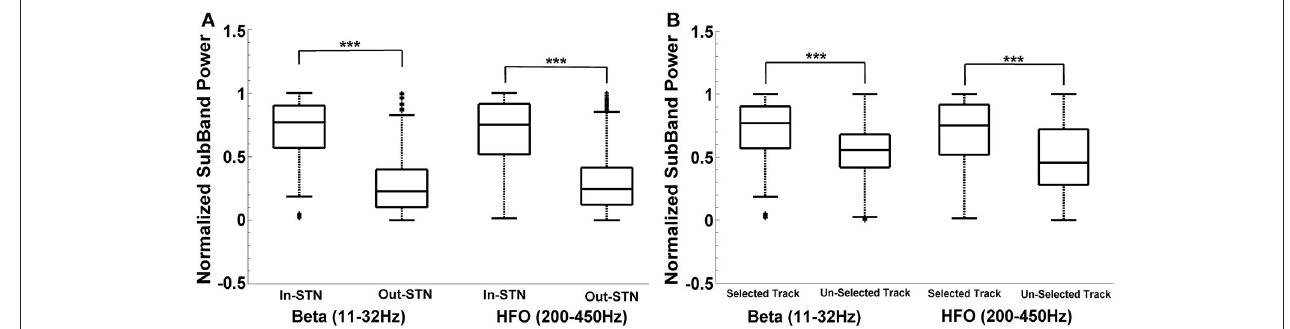
FIGURE 8 | Intra-track and inter-track differences of LFP spectra. Box plots demonstrate the normalized subband power of all subjects. Panel (A) shows the IN and OUT of STN power distribution in the selected track in beta (11–32Hz) and HFO (200–450Hz) bands. The sub-band power is much higher inside the STN. The difference between the power inside and outside the STN region (above the STN dorsal border) is statistically significant in each specified frequency band ( p < 0.001 ). Panel (B) shows the IN-STN power in the selected vs. un-selected tracks. Both distributions are statistically significant in each frequency bands. *** Statistically significant difference between distributions ( α = 0.01).